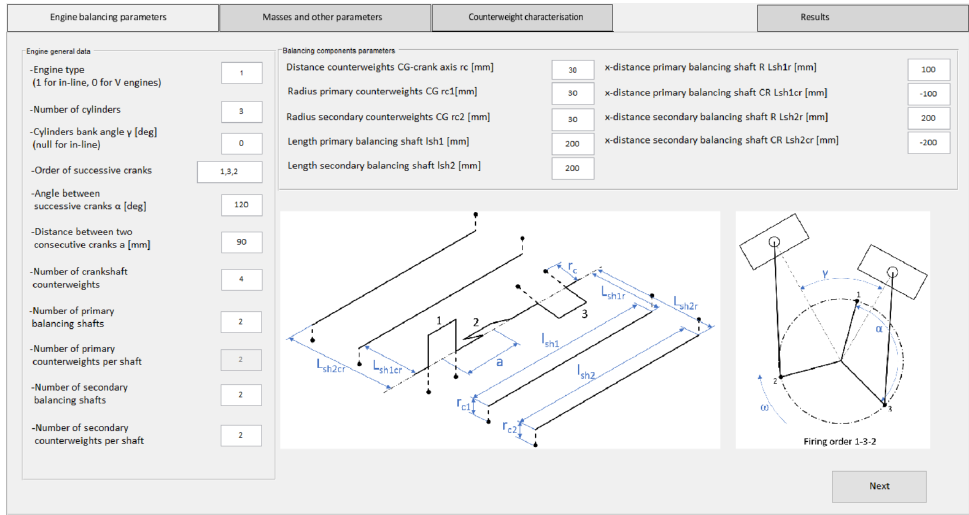
Figure 7. Tab of the user-interface dedicated to the insertion of the general and balancing input data.